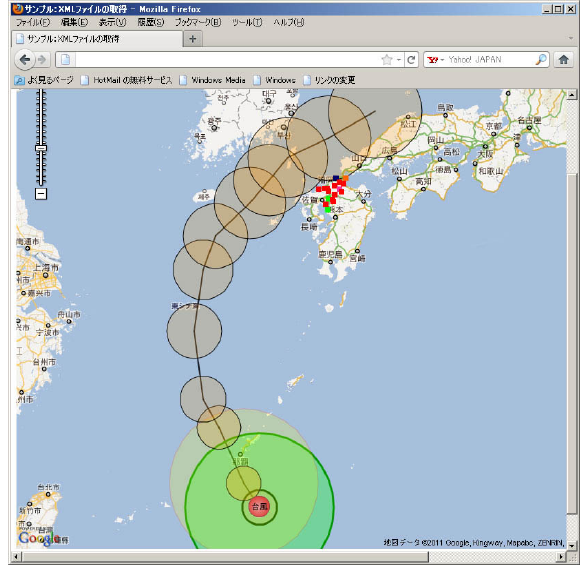
Figure 11. Typhoon scene and AMeDAS data on Google